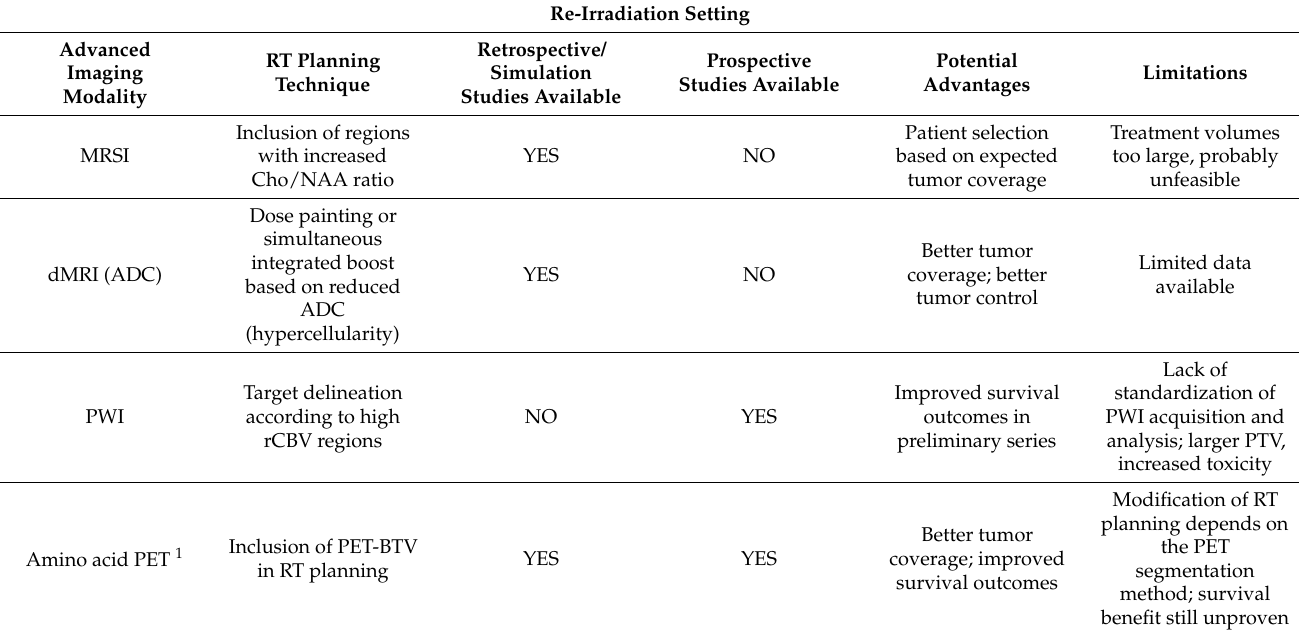
Table 2. Summary of findings of advanced imaging techniques in the re-irradiation setting of